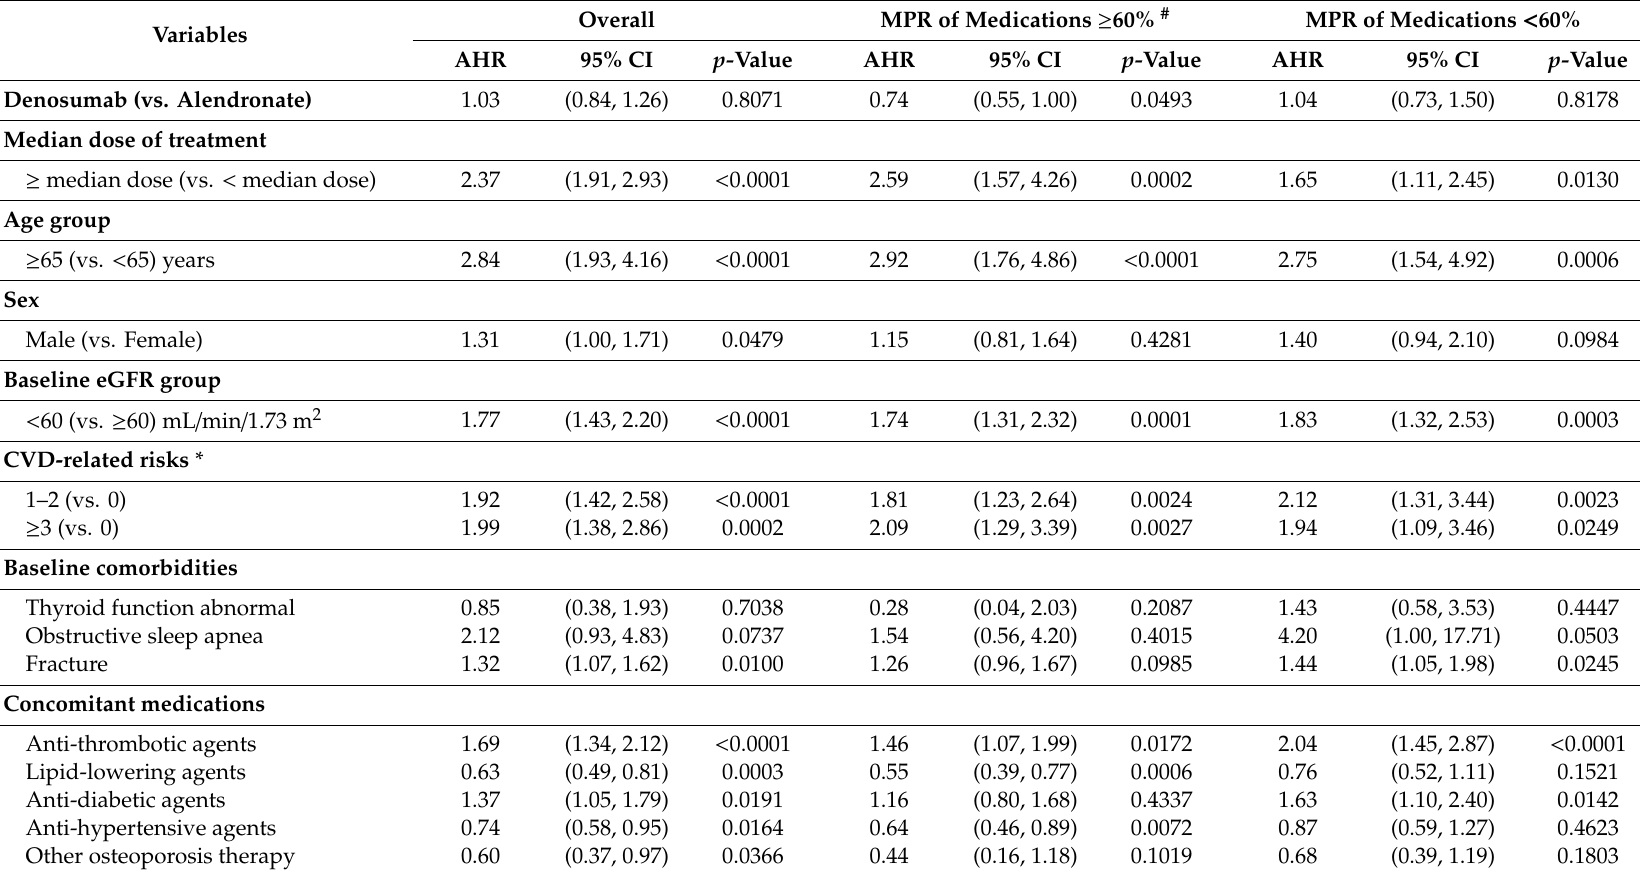
Table 3. Factors associated with risk of composite outcome of cardiovascular